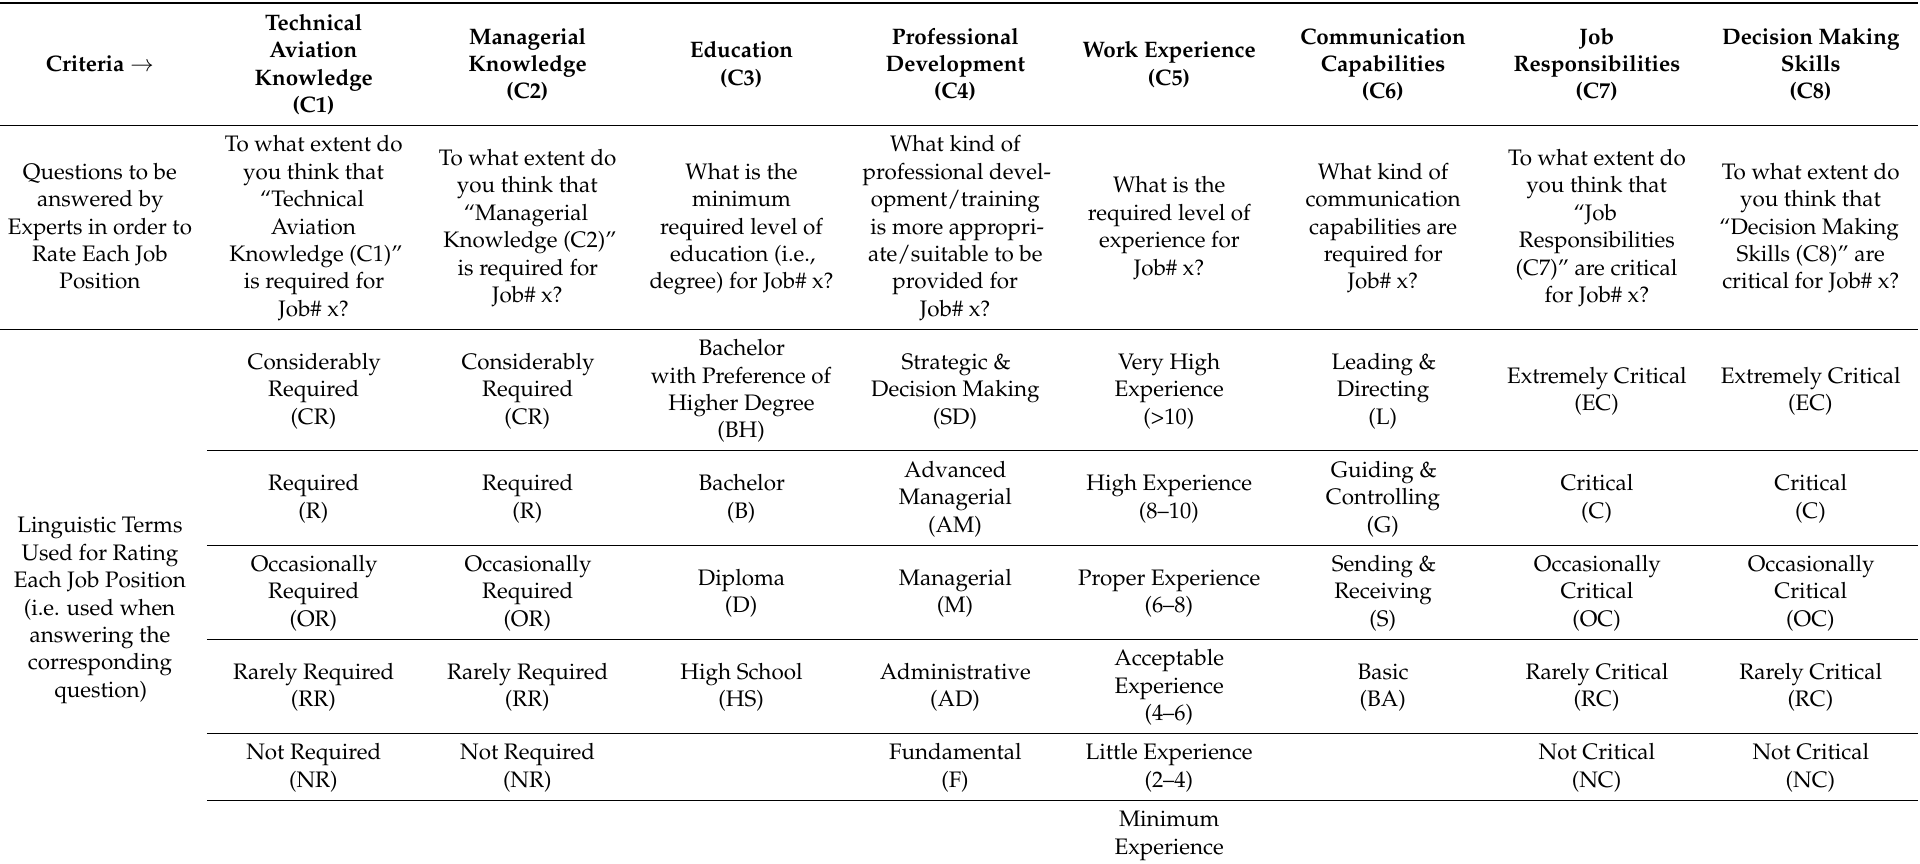
Table 2. Linguistic terms used in performing